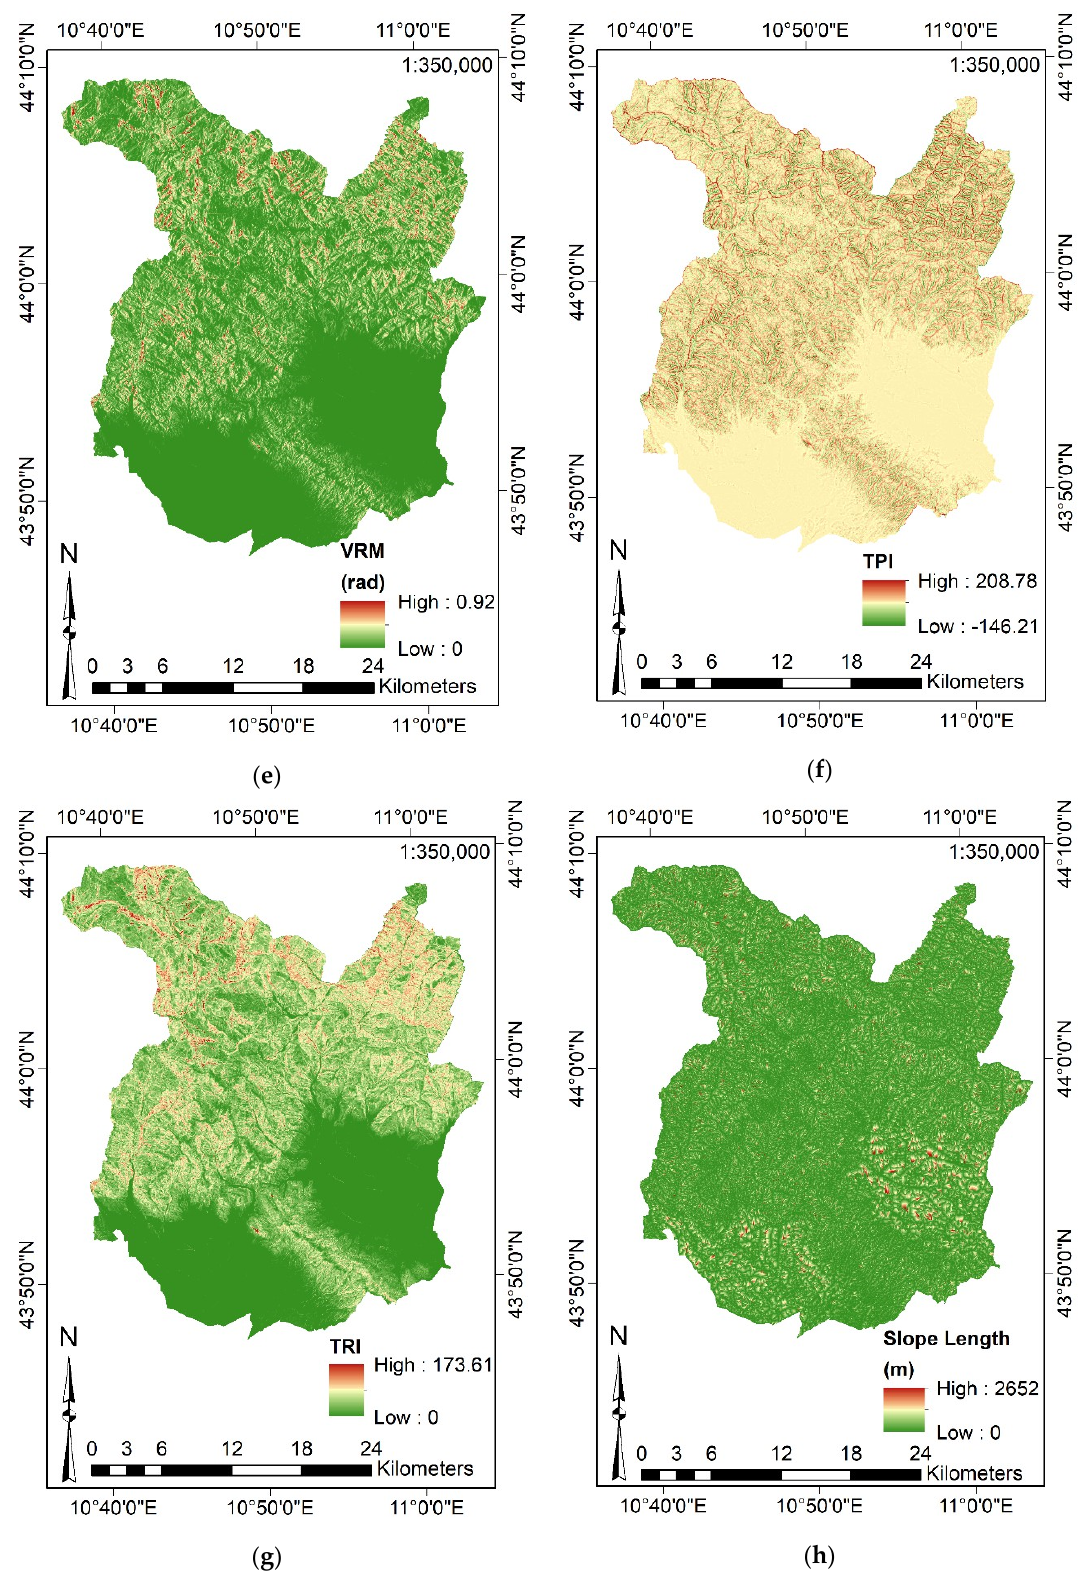
Figure A5. Input features—topographical-based computed factors: ( a ) Slope; ( b ) Aspect; ( c ) CI; ( d ) Curvature; ( e ) VRM; ( f ) TPI; ( g ) TRI; ( h ) SL.